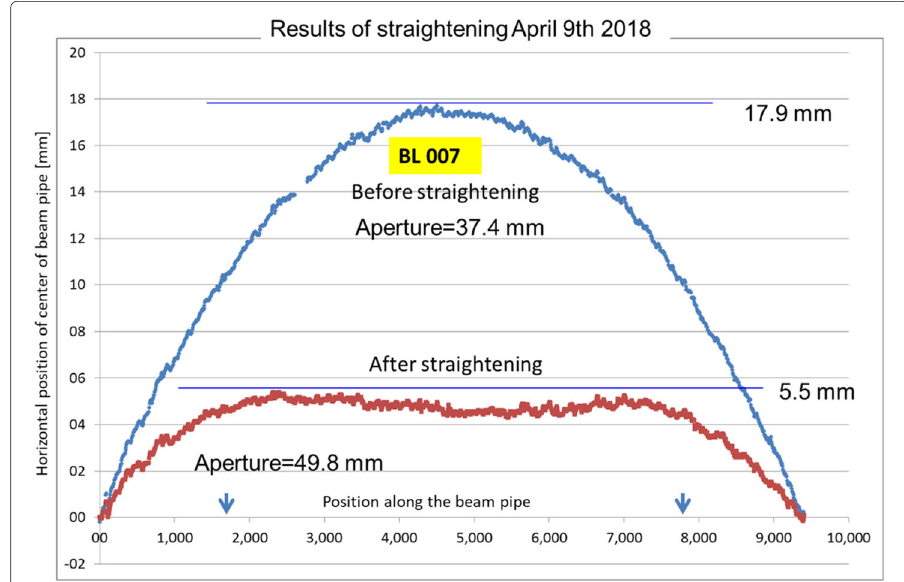
Fig. 15 The result of straightening a dipole. Shown is the measured center of the vacuum pipe before and after straightening. The positions of the outer pressure props are indicated by arrows. The maximum achievable aperture by the deformation is about 50 mm. The inner diameter of the beam tube is